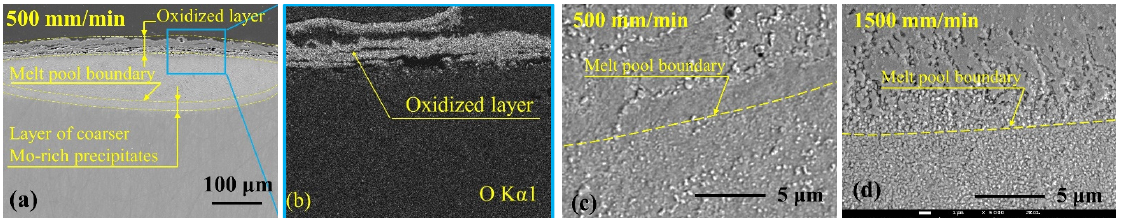
Figure 13. General view of the melt pool after aging ( a ) and oxygen distribution map of the melt pool top ( b ), plenty precipitation of molybdenum rich particles in parent metal near the melt pool boundary ( c ) and ( d ).